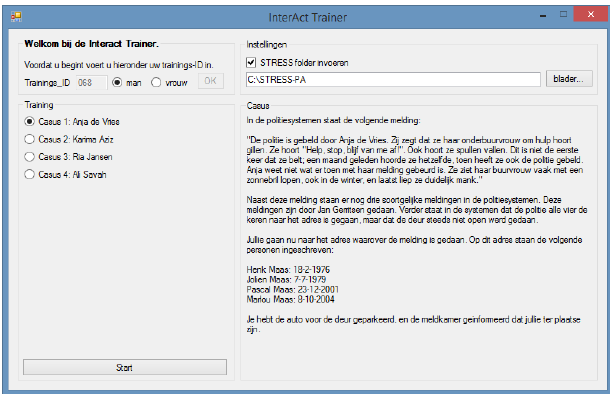
Figure 3. Start menu of the training software (in